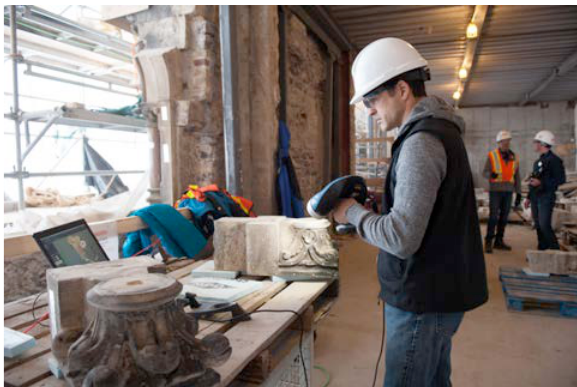
Figure 1. Data capture with a Creaform HandySCAN 3D handheld scanner.